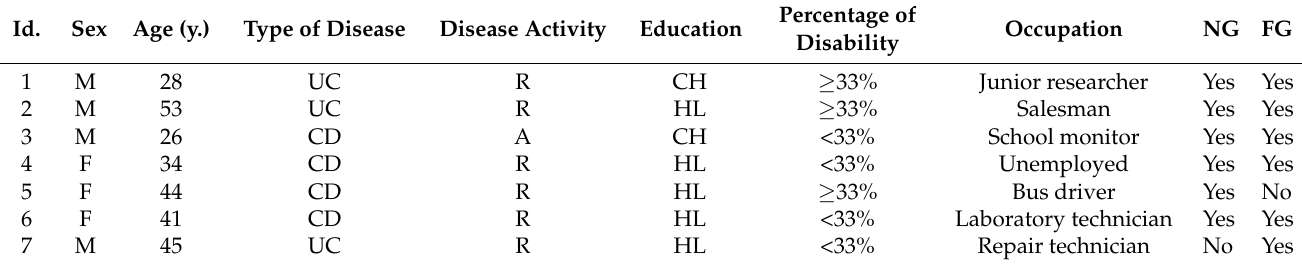
Table 1. Details of